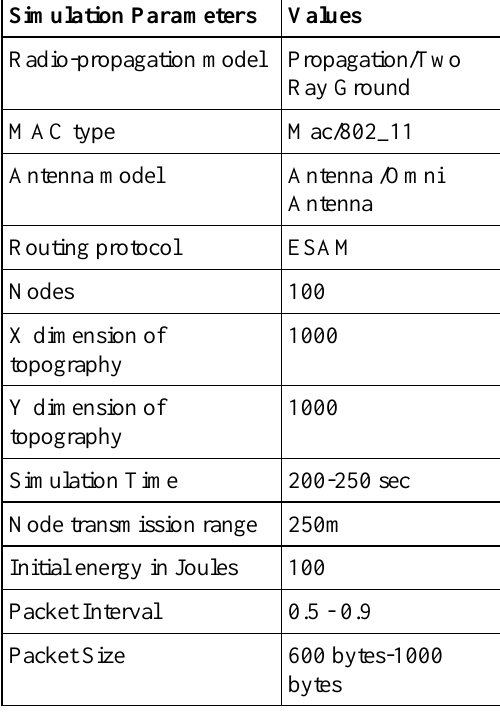
Table 2. Simulation